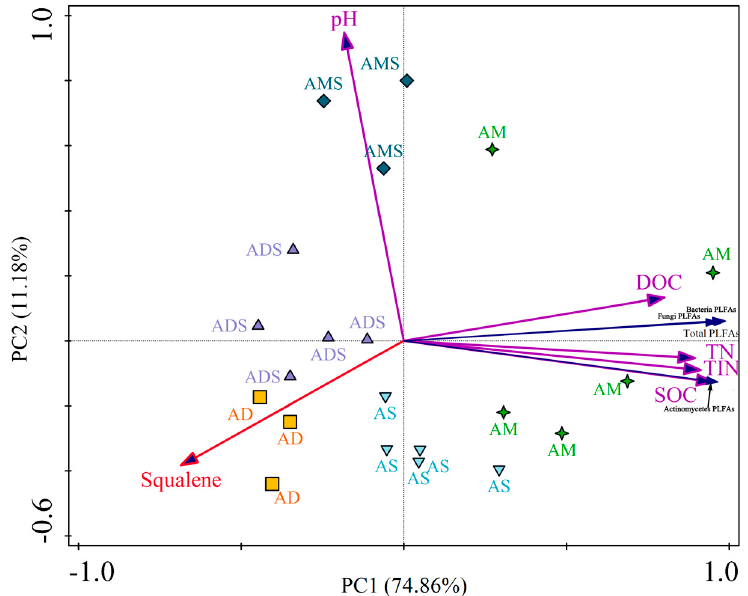
Figure 3. The relationships between squalene relative abundances and soil chemical/microbial